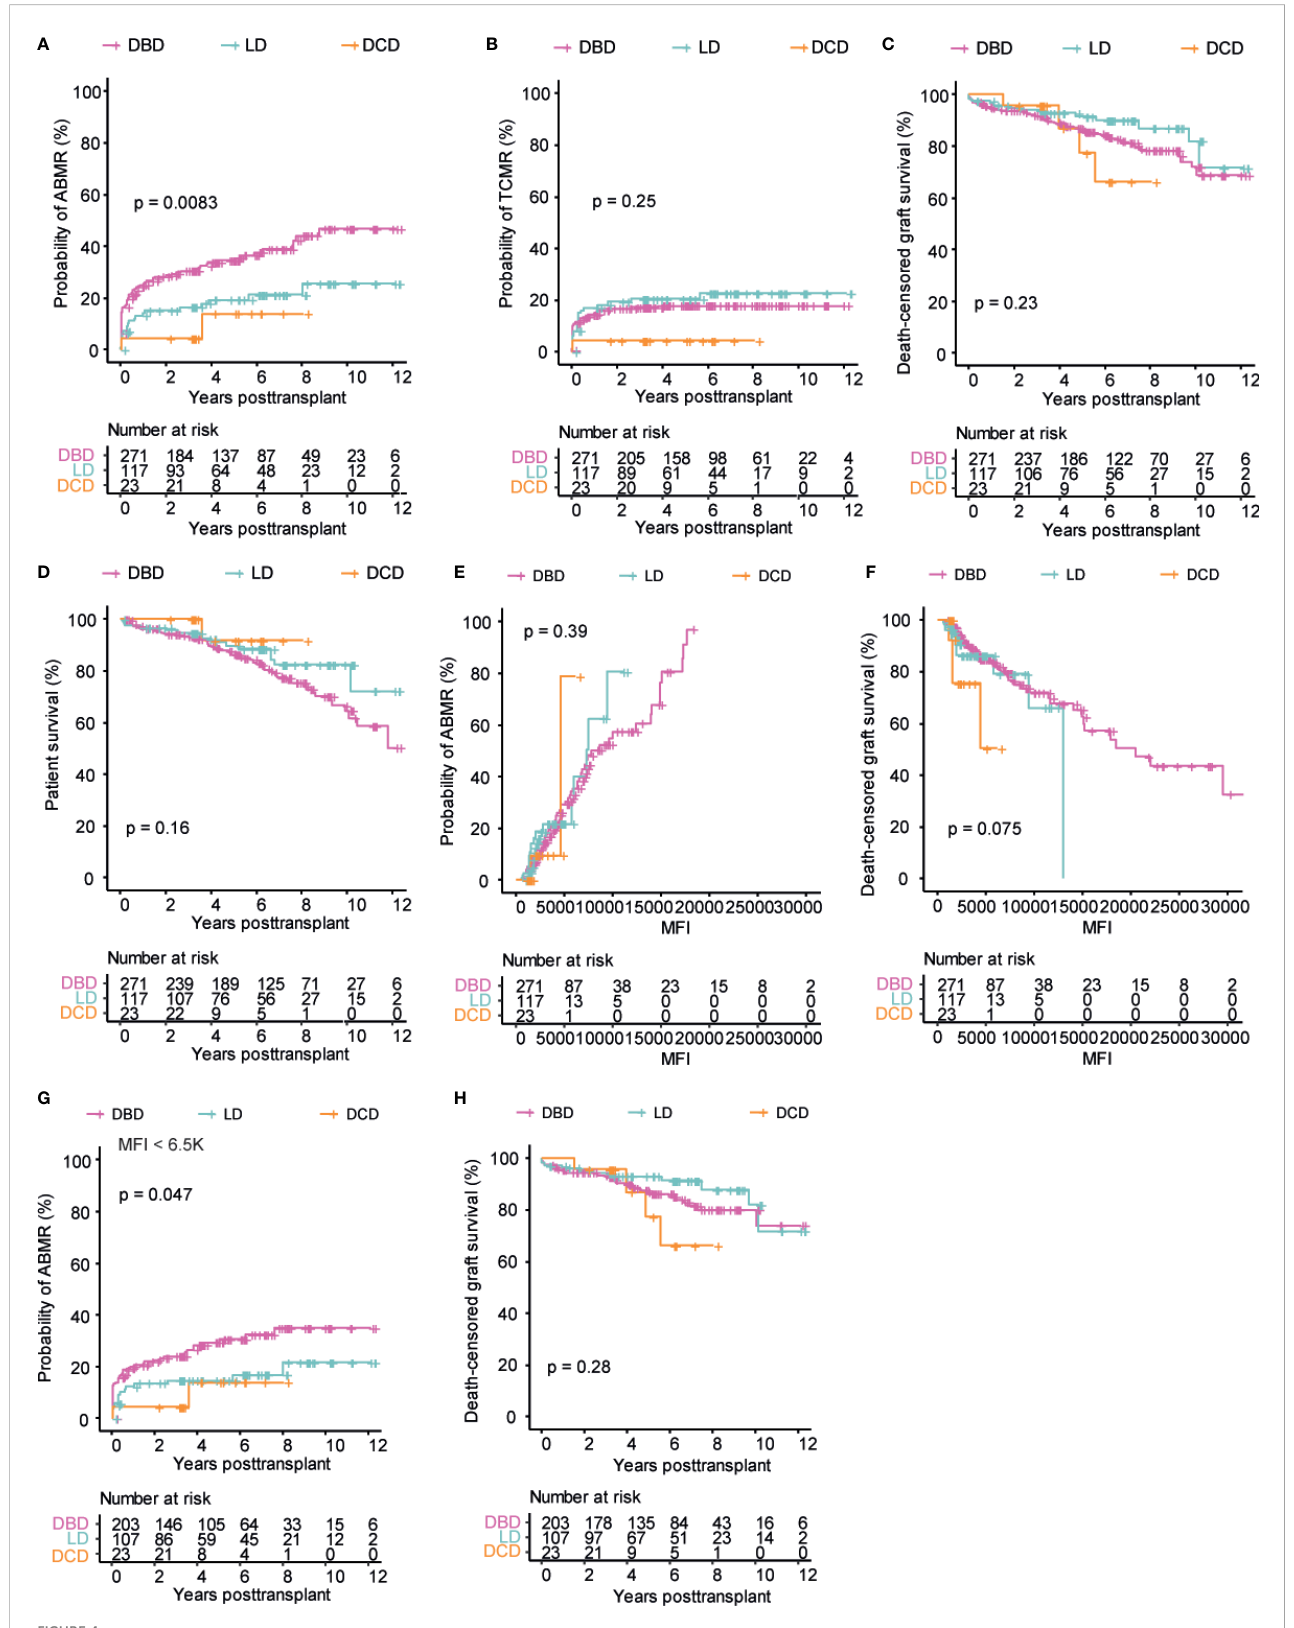
FIGURE 4 Comparable outcome in DSA positive patients among three different donation types. Cumulative incidence of ABMR (A) , TCMR (B) , patient survival (C) , and death-censored graft survival (D) over time in DSA positive patients. Cumulative incidence of ABMR (E) , and death-censored graft survival (F) with regards to cumulative DSA MFI value. Cumulative incidence of ABMR (G) , and death-censored graft survival (H) in patients with a DSA MFI value below 6.5k. Log-rank test was used to test p value of the Kaplan-Meier survival curves for all the